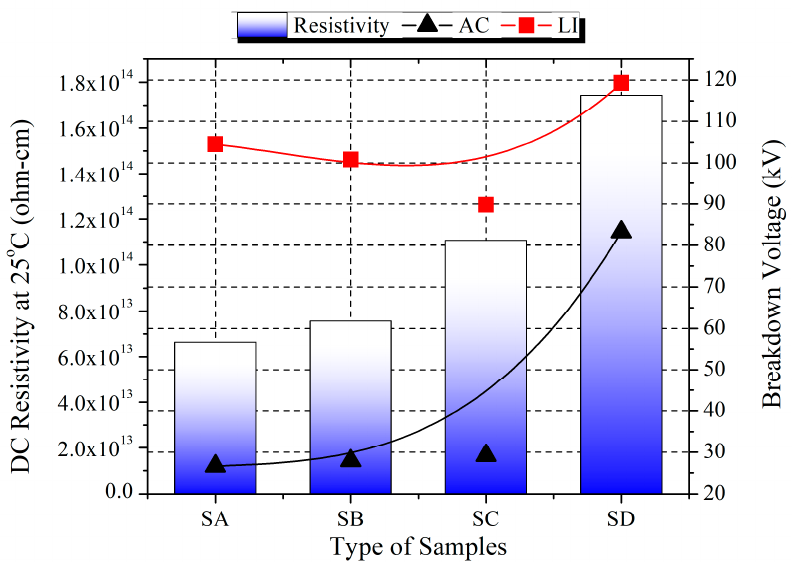
Figure 19. Influence DC resistivity of oil samples towards breakdown voltage and lightning impulse measurements at ambient temperature.